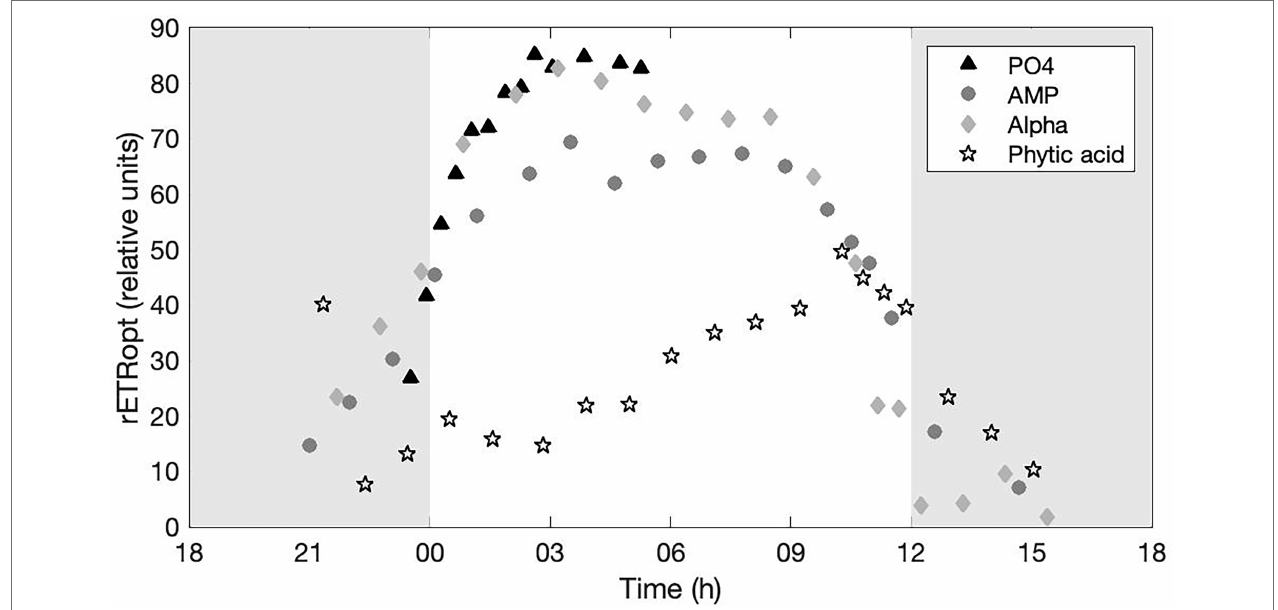
FIGURE 5 | Optimal, relative electron transport rate (rETR opt ) monitored in cultures provided with either an inorganic (PO 4 ; triangles) or organic [mono phosphate adenosin (AMP; circles), DL- α -glycerophosphate (Alpha; diamonds) or phytic acid (Phytic acid; pentagrams)] source of phosphorus for growth. The grey, shaded area represents the dark